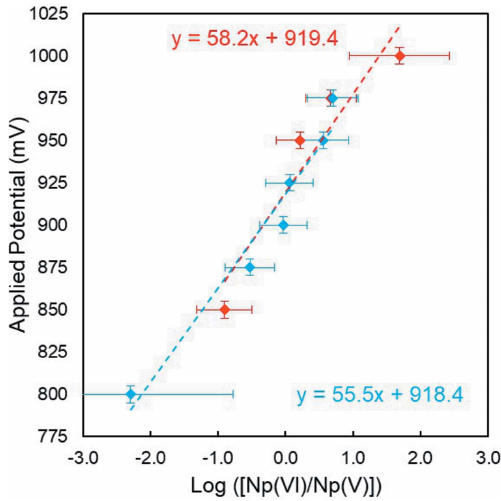
Figure 3 Nernst plots obtained from XANES measurements. Red diamonds correspond to the oxidizing experiment and blue diamonds to the reducing experiment. The dashed lines are the linear